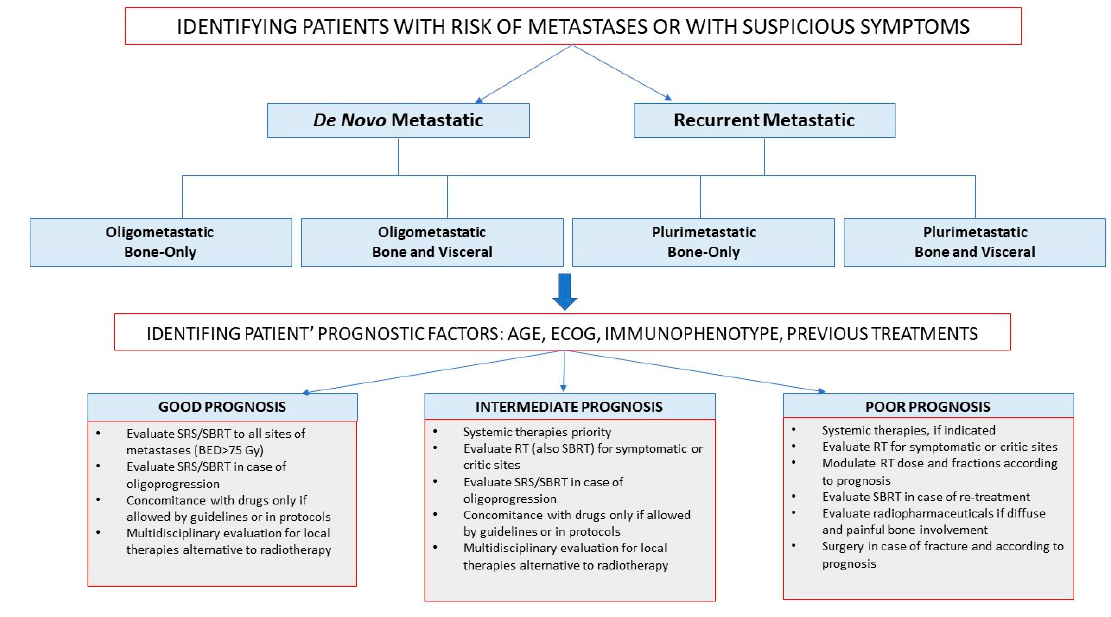
Figure 2. Therapeutic algorithms approach to patients with Bone metastases from breast cancer according to good, intermediate or poor prognosis.